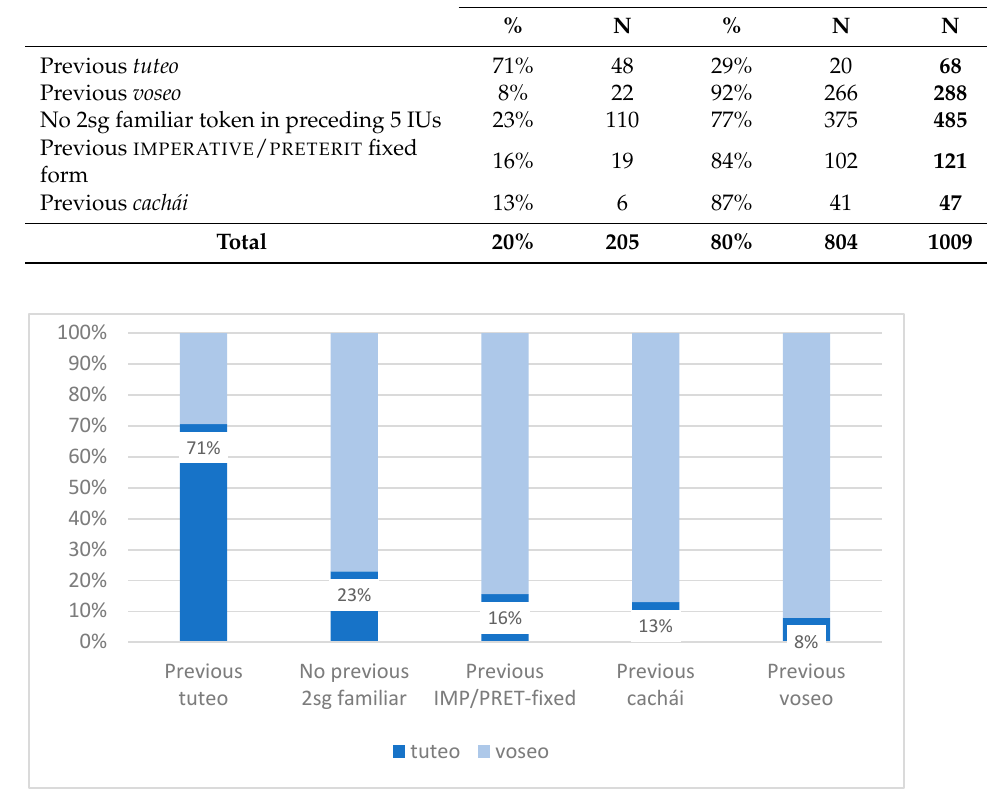
Figure 3. Rates of tuteo vs. voseo by previous realization.